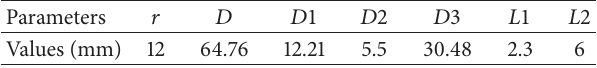
Table 10: Dimensions of the 3D spherical antenna (Figure 17).